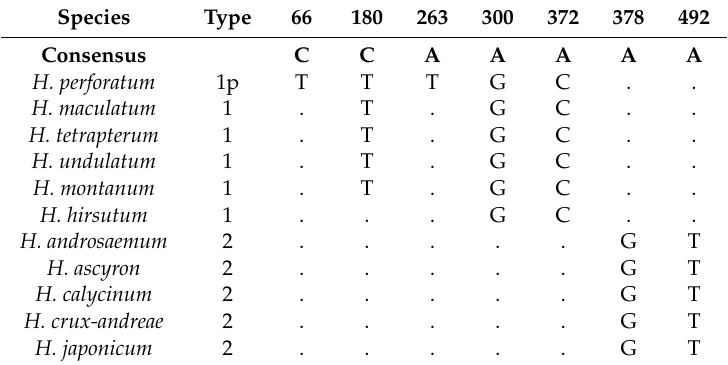
Table 3. Haplotype map of the rbc L region, showing shared patterns of polymorphism between groups of species. Dots indicate compliance with the consensus sequences.